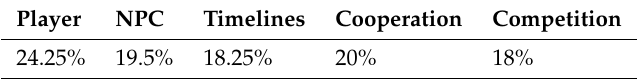
Table 9. Category distribution in the processed dataset (Source: